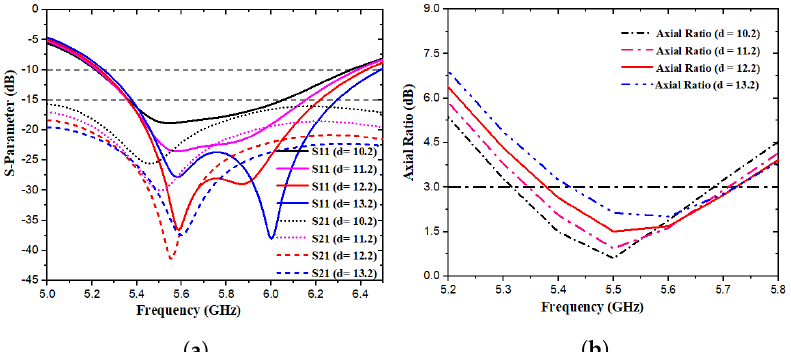
Figure 8. ( a ) S-parameters of different plots for various distances ( d ). ( b ) Axial ratios of different plots for various distances ( d ).